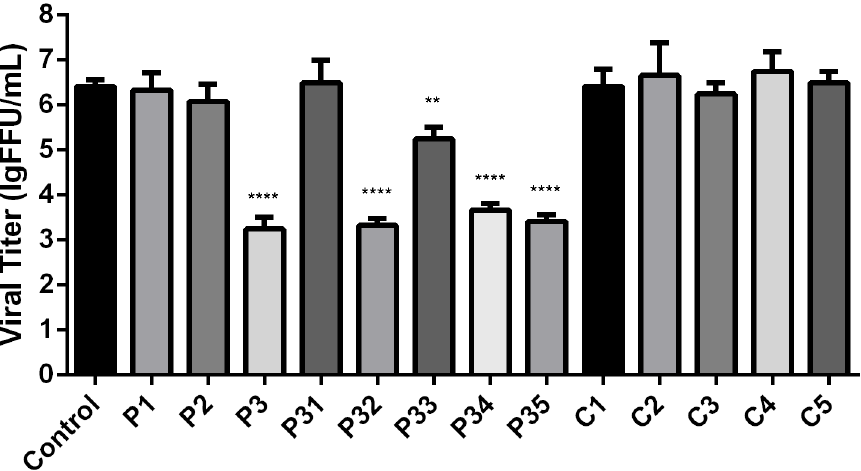
Each value is expressed as the mean ± SEM from three independent experiments. ( ** , P < 0.01; **** , P < 0.0005).